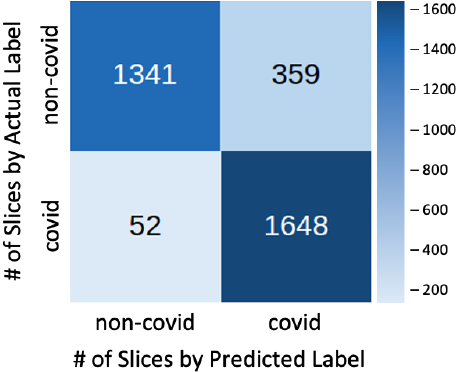
Figure 3. Best Parameters Results Confusion Matrix.